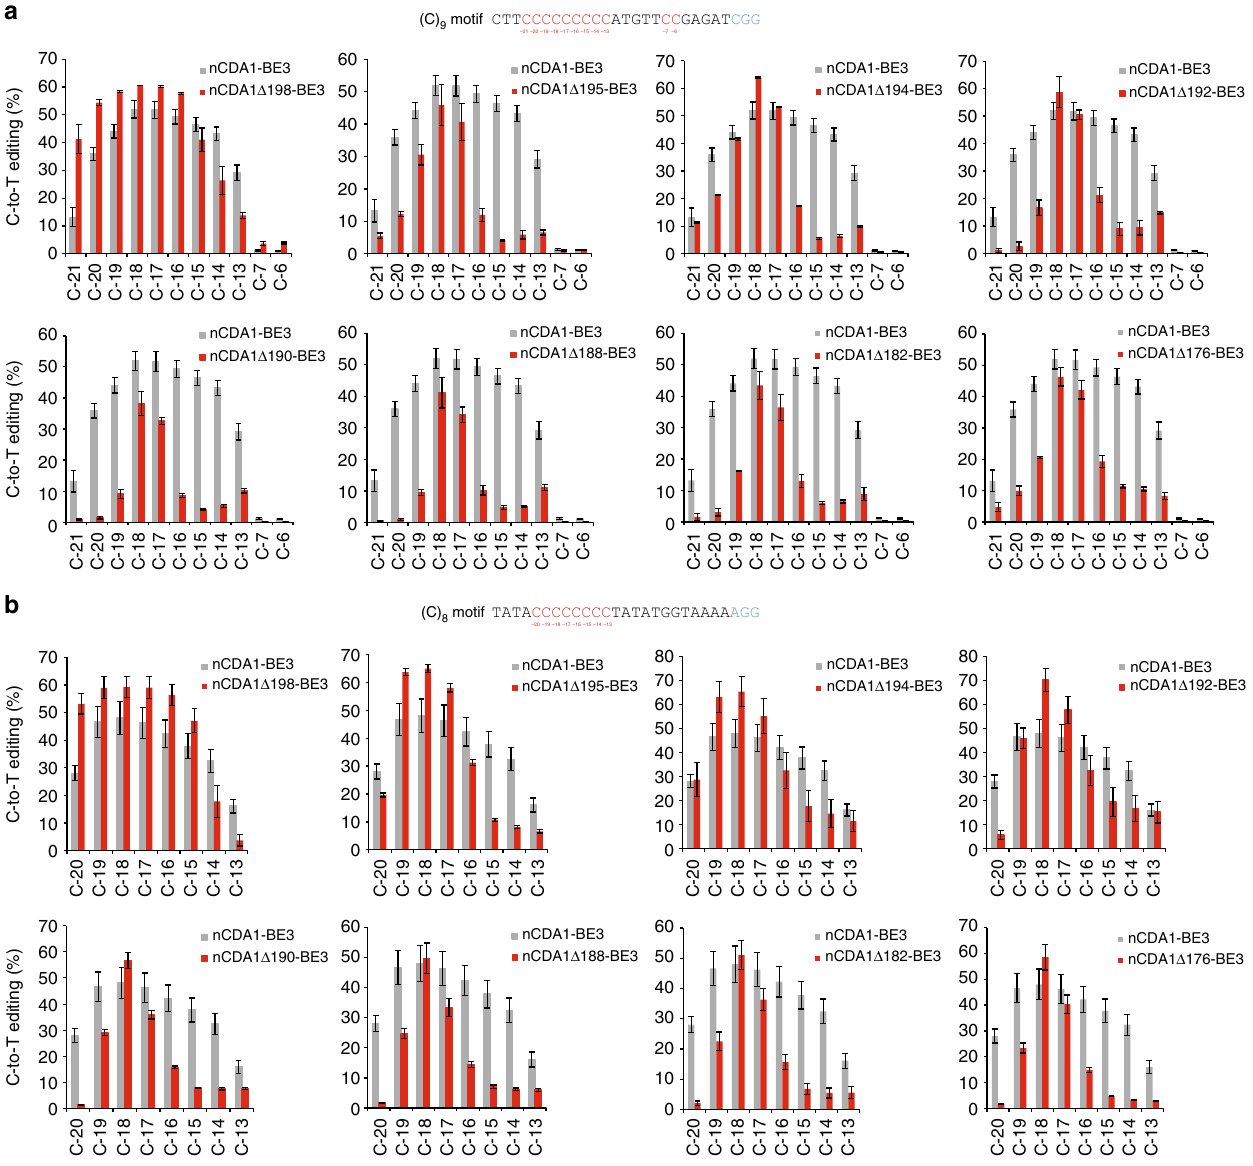
Fig. 4 Effects of C-terminal truncations of the CDA1 domain on the width of the editing window of nCDA1-BE3 base editors. All base editor variants were tested on both (C) 8 ( a ) and (C) 9 ( b ) motifs (see Methods). Cs within each target region are shown in red, with the number below indicating their distance from the PAM (blue). The C-to-T conversion ef fi ciencies are plotted for all Cs within the protospacer, and shown in comparison to the nCDA1-BE3 base editor with the full-length CDA1 (gray bars). Values and error bars represent the mean and standard deviation of three biological replicates. Source data are provided as a Source Data fi le. For a comparison with additional deletion constructs, see Supplementary Figures 10 and